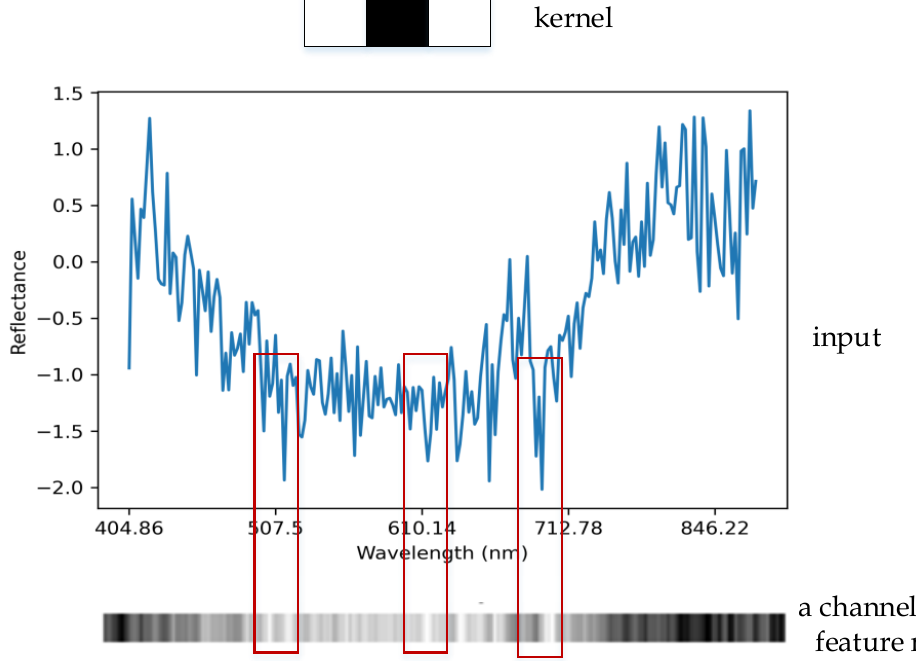
Figure 3. Convolution process with input spectral signal and a kernel size of 3 to produce local